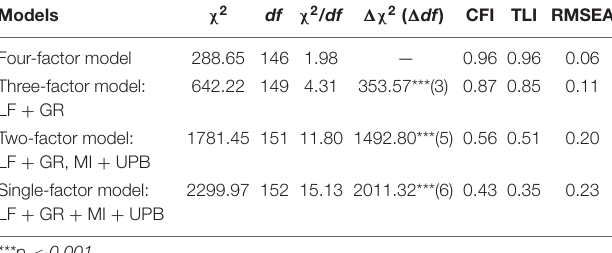
TABLE 2 | Results of confirmatory factor analysis.